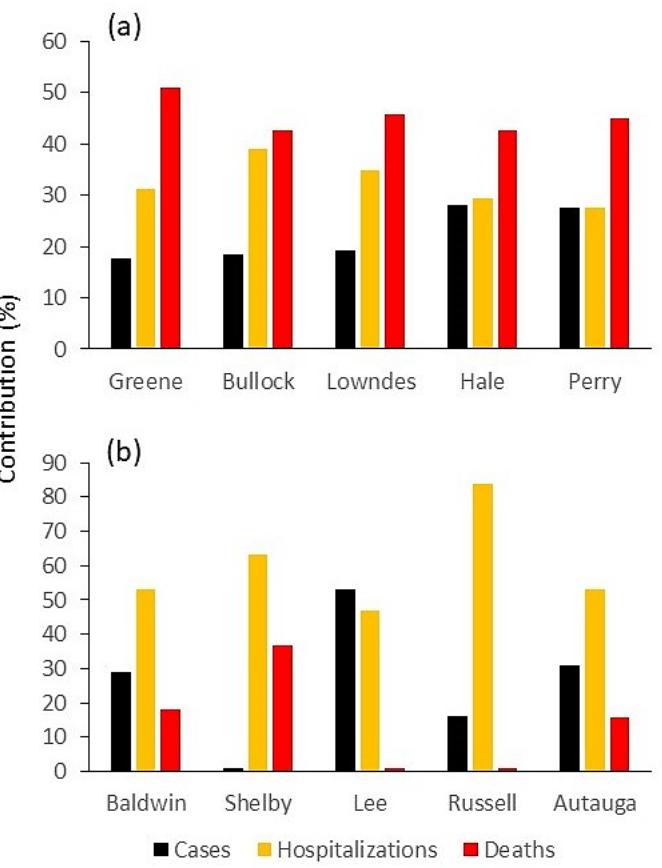
Figure 3. Spatial distribution of the exposure subindex. The scores are classified as quintiles. The thick black lines indicate the boundaries of Black Belt counties.